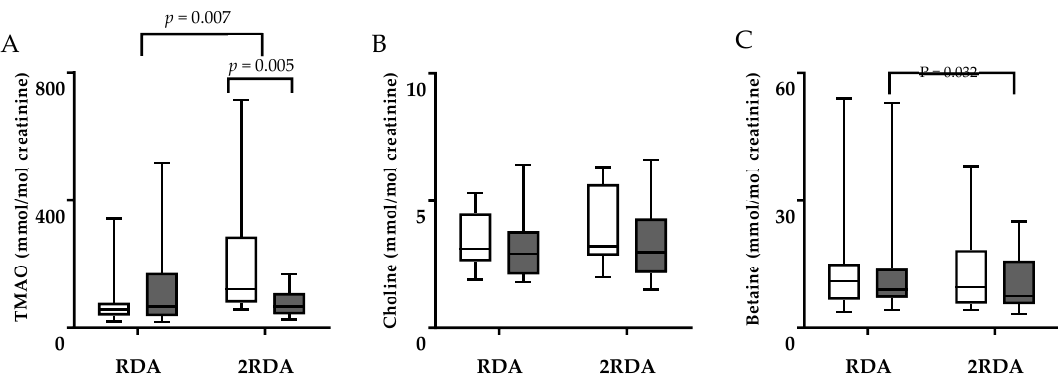
Figure 2. Box whisker plots illustrating concentrations of ( A ) TMAO, ( B ) choline, and ( C ) betaine in urine of the RDA and 2RDA groups pre-intervention (uncoloured boxes) and after 10 weeks (coloured boxes). The central lines represent means and the error bars represent minimum and maximum values. TMAO: trimethylamine-N-oxide. Two-way repeated measures ANOVA was used for